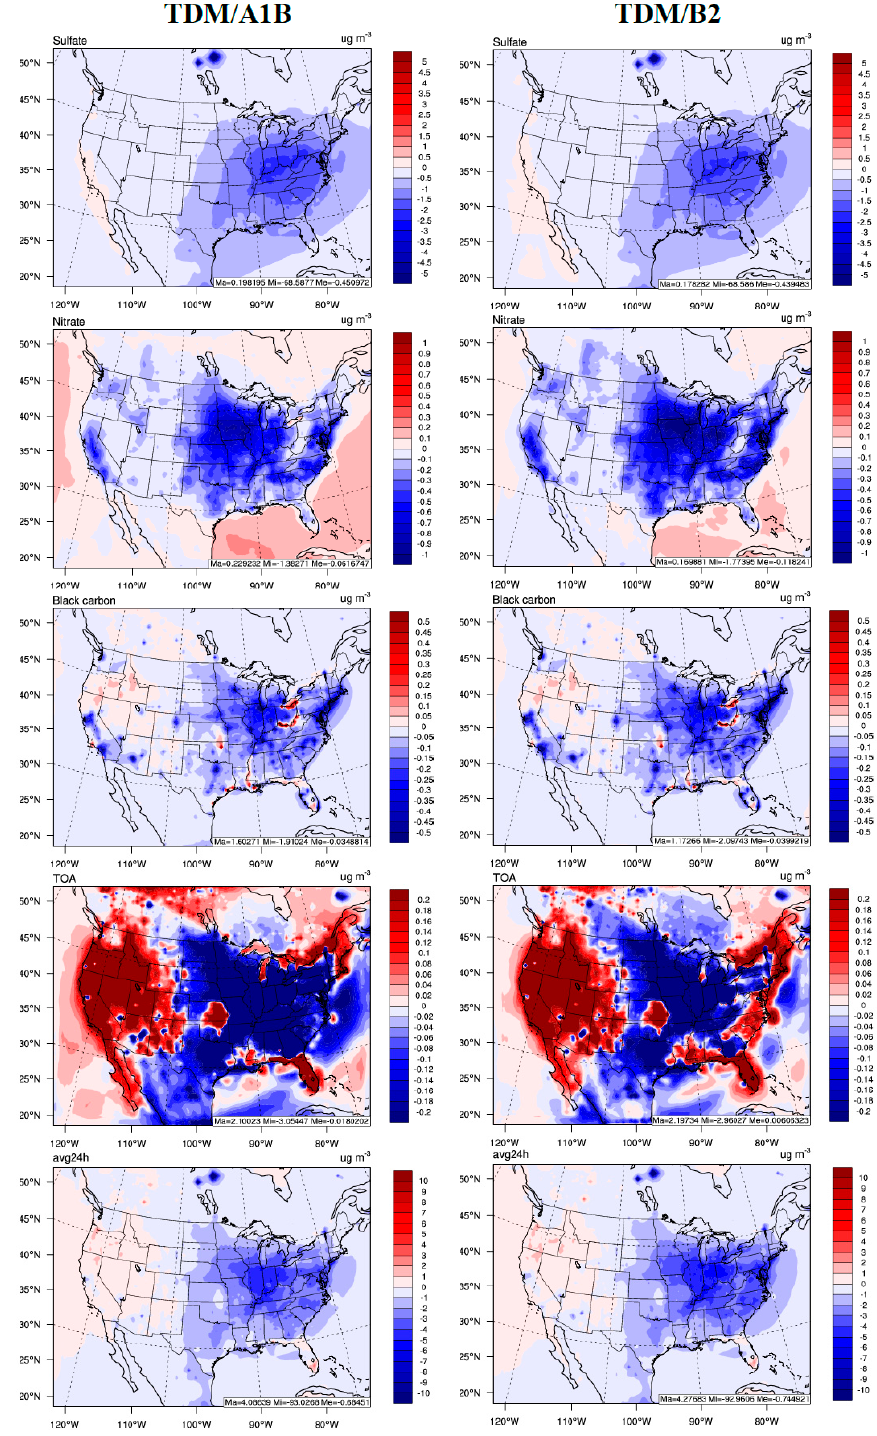
Figure 4. Absolute changes of annual average sulfate (SO 42 − ), nitrate (NO 3 − ), black carbon (BC), total organic aerosol (TOA), and daily average PM 2.5 (DA24 h) between the future and current decade for TDM/A1B and TDM/B2.